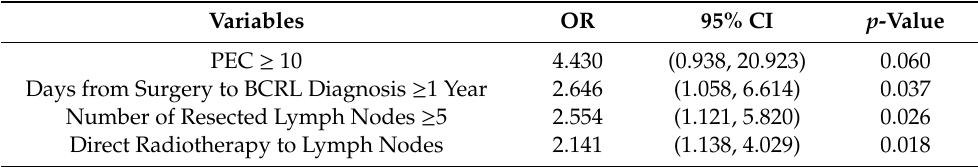
Table 4. Multivariate logistic regression analysis for the compression-dependent group ( n = 203). Variables OR 95% CI p -Value PEC ≥ 10 4.430 (0.938, 20.923) 0.060 Days from Surgery to BCRL Diagnosis ≥ 1 Year 2.646 Number of Resected Lymph Nodes ≥ 5 Direct Radiotherapy to Lymph Nodes 2.141 (1.138, 4.029)